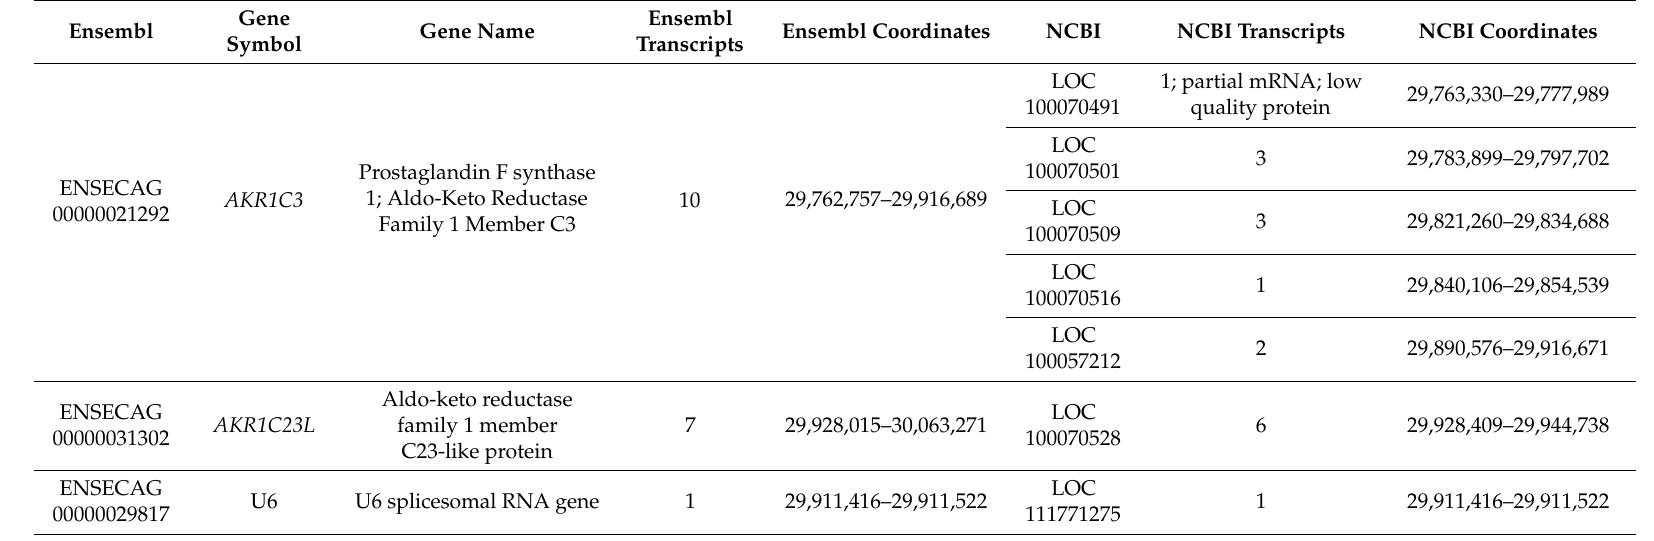
Table 2. Predicted genes in the deleted region by Ensembl and their counterparts by NCBI